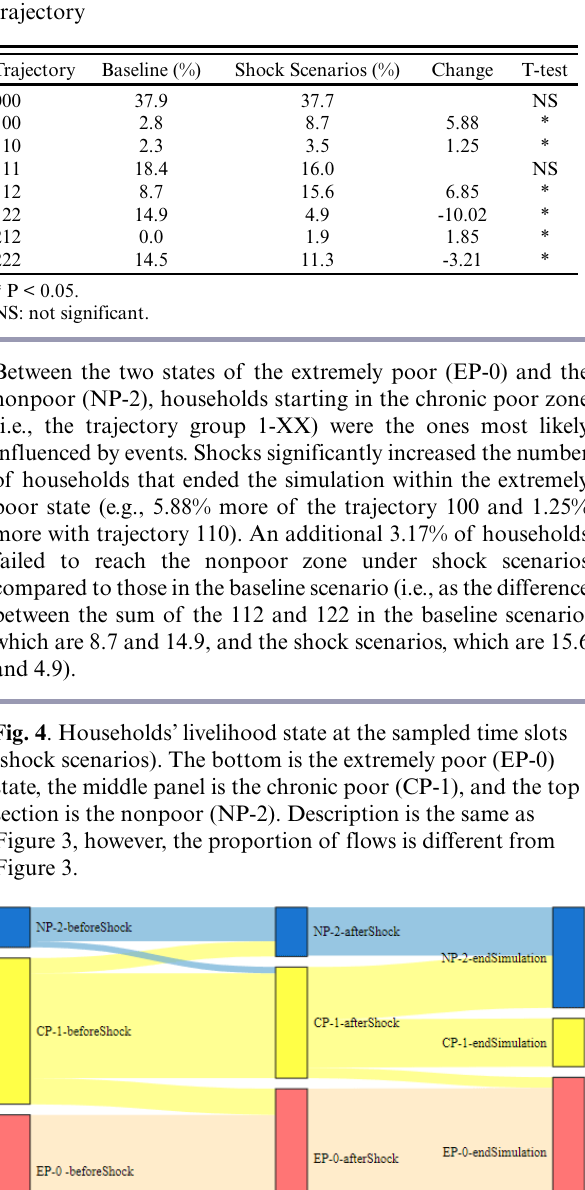
Table 3 . Percentage change of households in every livelihood